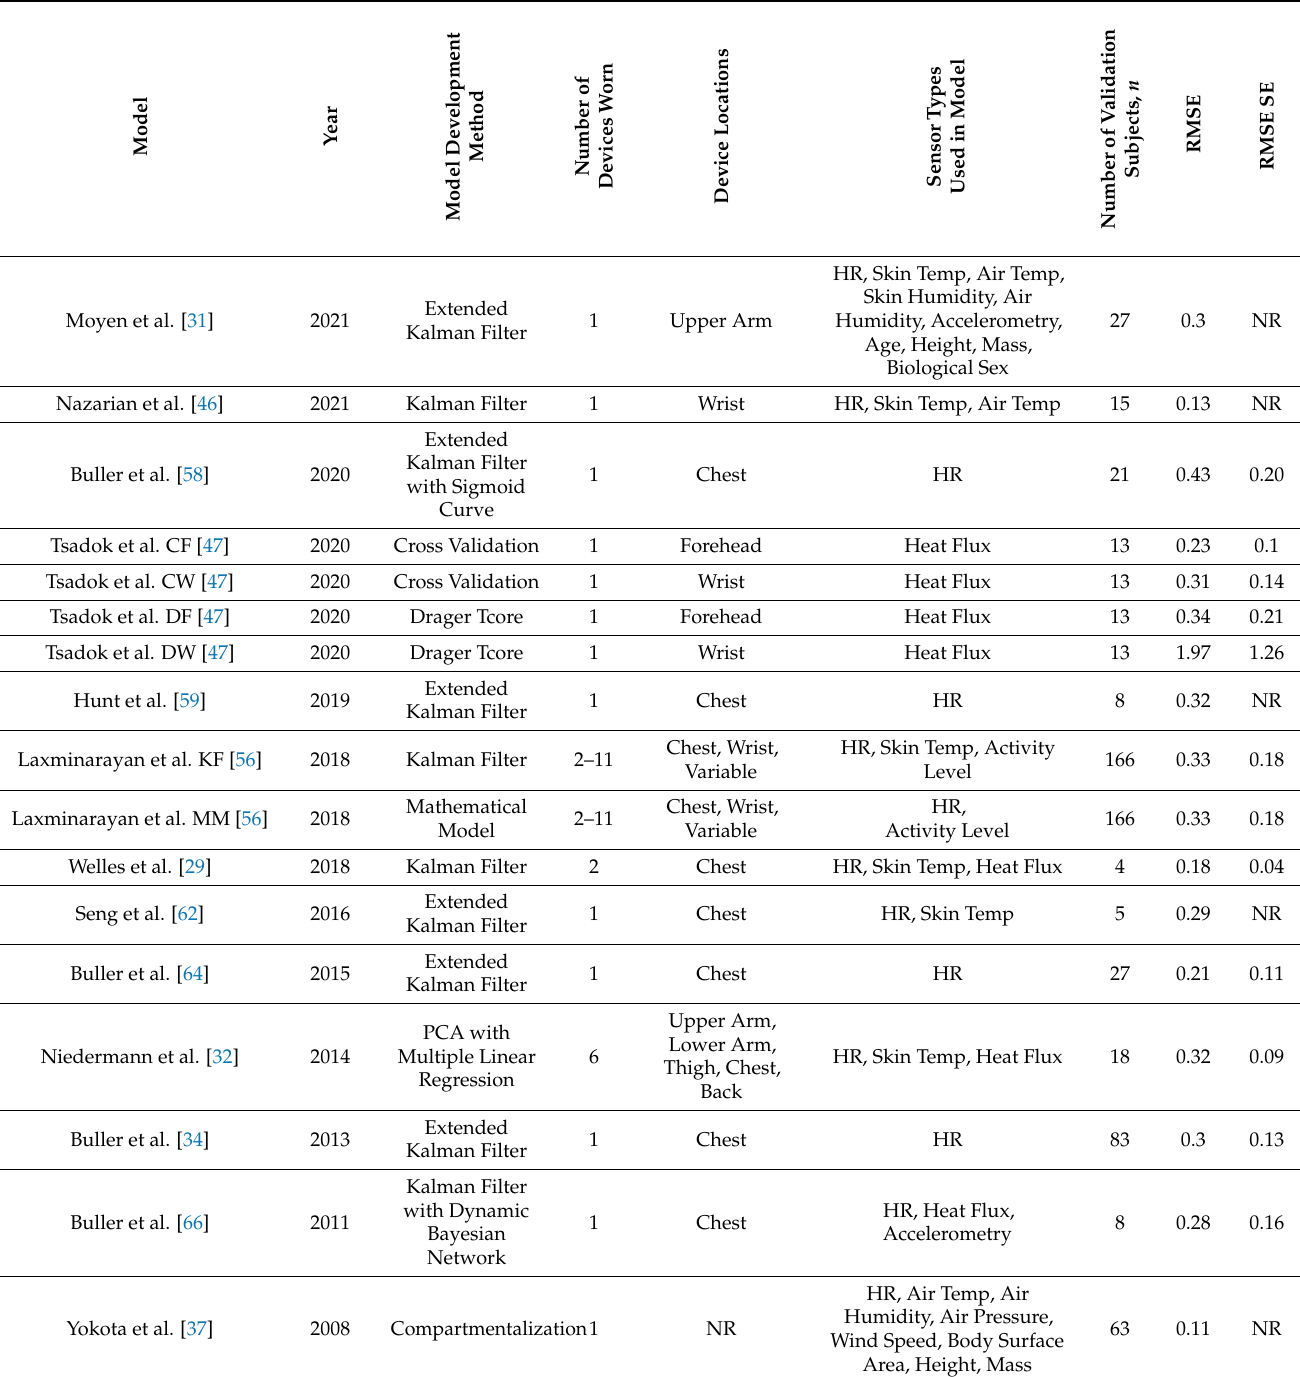
Table 4. Data on the model design and outcomes for models that reported the root mean square estimate (RMSE). NR: Not Reported and V =